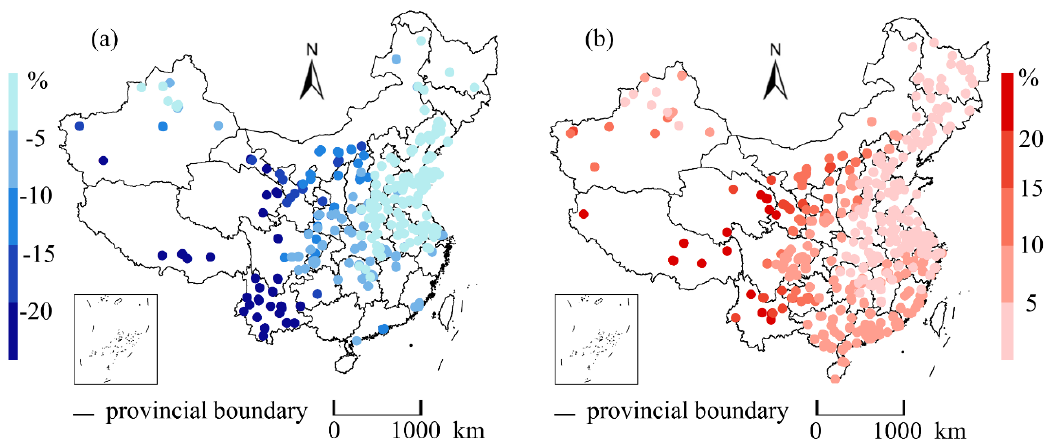
Figure 4. Reported ( a ) under- and ( b ) over-estimated changes (%) of the 12-month average PM 2.5 concentrations from September 2017–August 2018 (first period) and September 2018–August 2019 (second period), due to the monitoring protocol amendment effective since September 2018. Underestimation means that the actual degree of concentration increase between these two periods is larger than the reported. Overestimation means the actual degree of concentration decline is smaller than the reported.